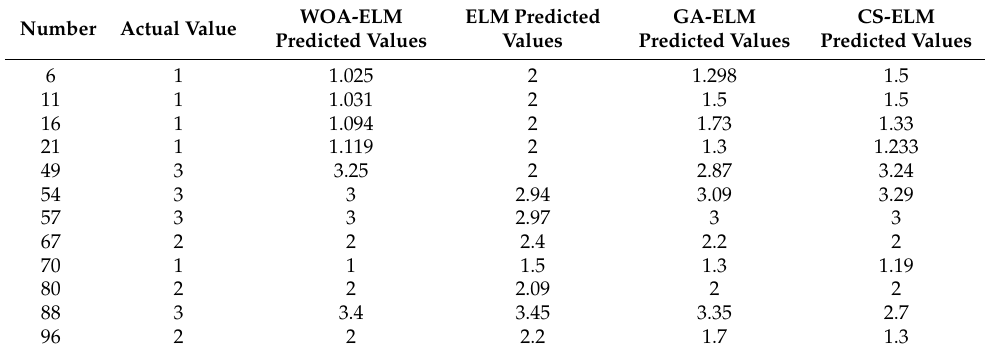
Table 9. Sample deviations of some gas outburst hazard